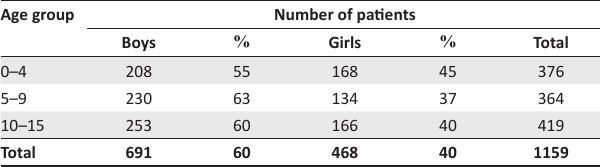
TABLE 2: Distribution of childhood cancers according to patient age group and sex ( n = 1159). Age